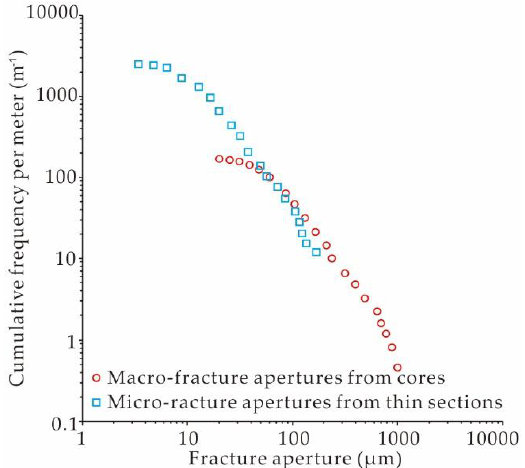
Figure 8. Cumulative frequency plots of micro-fracture apertures (blue squares) and macro-fracture apertures (red circles).